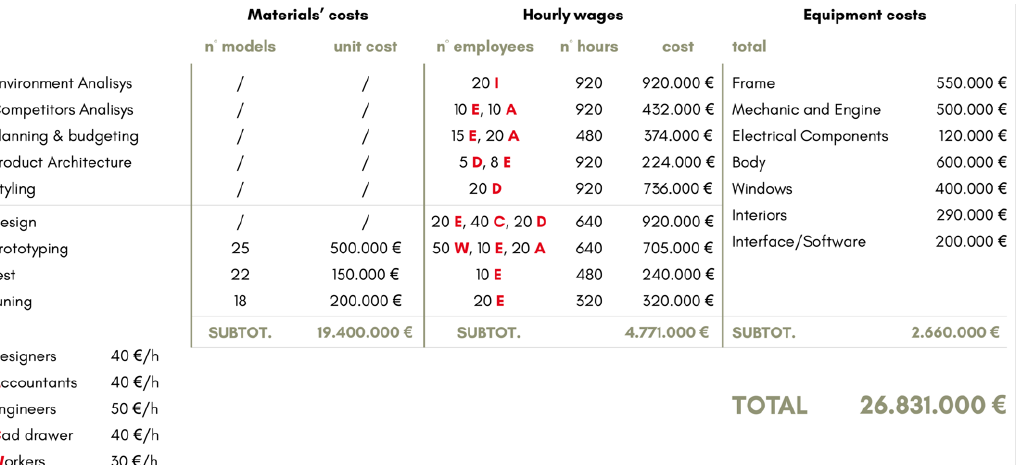
Figure 13. Time-based Budget Planning.